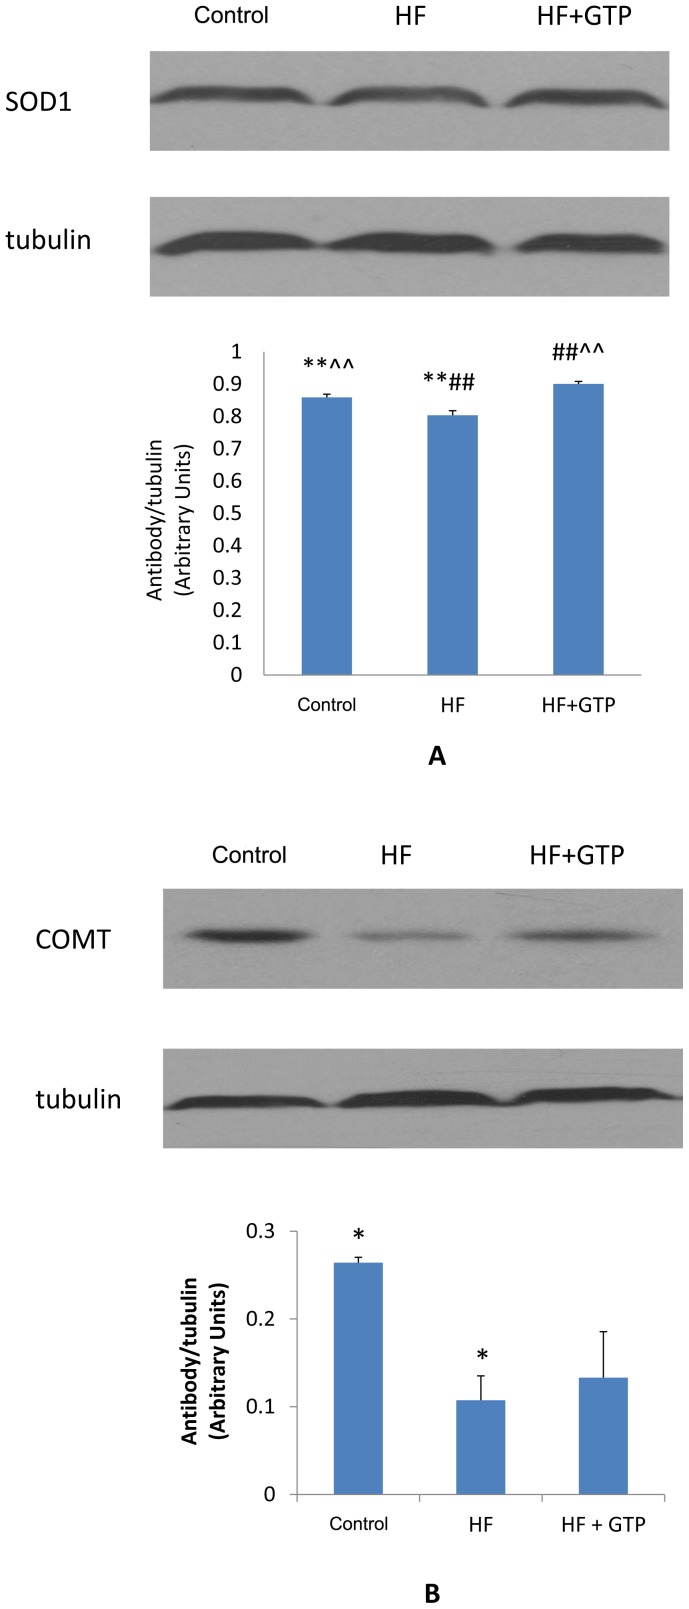
Western blot analyses of protein expression in the control, HF, and HF+GTP groups.(A) Effects of HF and HF+GTP treatment on the protein expression of SOD1. (B) Effects of HF and HF+GTP treatment on the protein expression of COMT. Blots were also probed for α-tubulin to confirm equal protein loading. The relative protein intensities of SOD1 and COMT were compared with the intensity of α-tubulin. The intensity of each band was quantified using Quantity One software. Data are means±SE, n = 3. The experiments were conducted in triplicate. * P<0.05 between the control and HF groups; ** P<0.01 between the control and HF groups; ## P<0.01 between HF and HF+GTP; ∧∧P<0.01 between the control and HF+GTP groups.